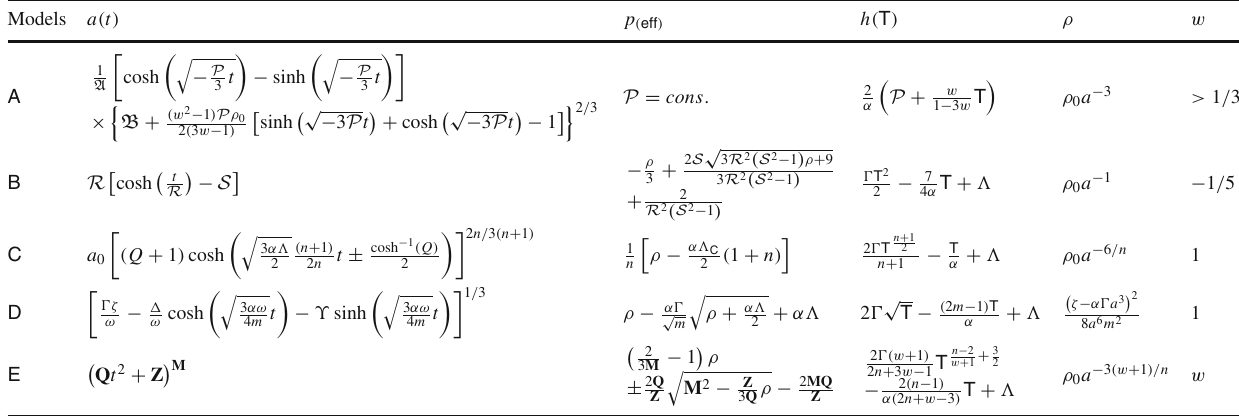
Table 1 Different bouncing solutions and their main properties* Models a ( t